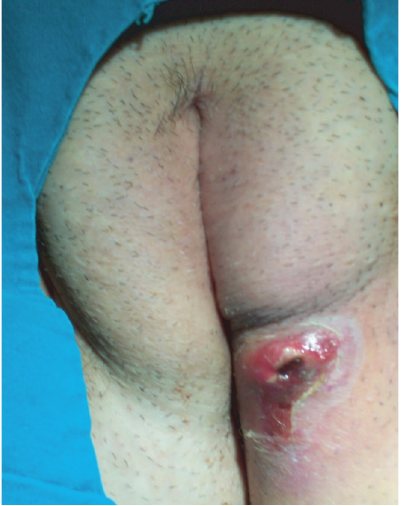
Figure 1: Vulvar abscess (The lesion is 5 × 4 cm in size, red, and